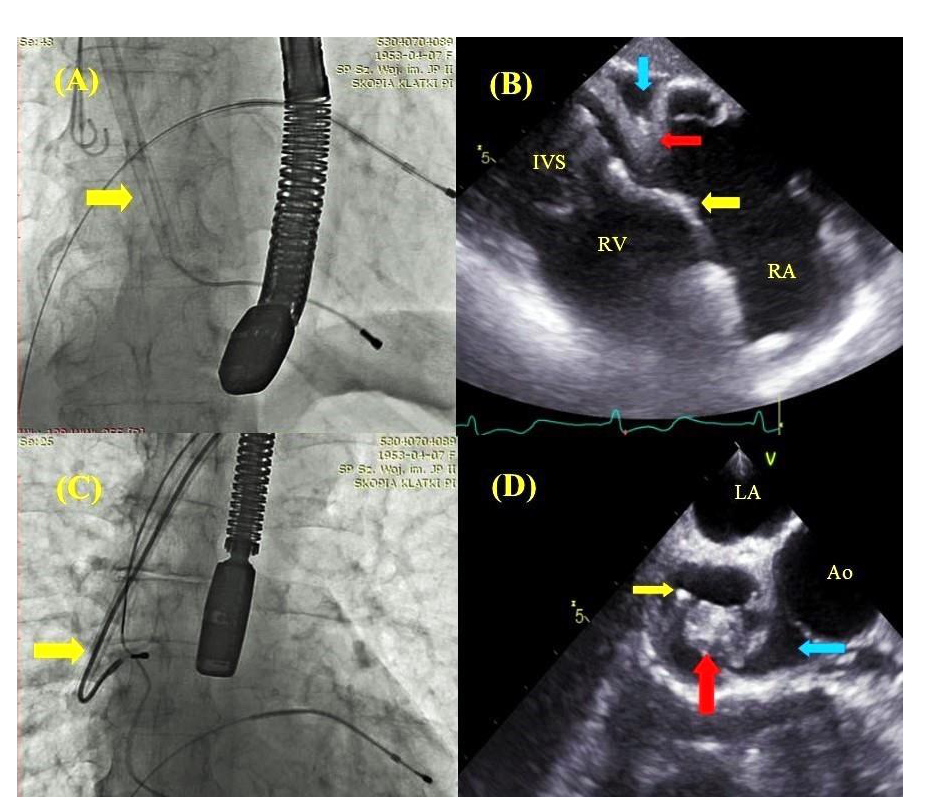
Figure 4. Comparison of fluoroscopic and echocardiographic images during lead extraction maneuvers. The moment of ventricular lead extracting; the yellow arrow points to the Byrd dilator slipped over the lead ( A ). TEE—transgastric view—the moment of ventricular lead extraction ( A ) with pulling on the right ventricular (RV) wall (red arrow), hyperechogenic thickened lead adhered to the endocardium (yellow arrow), the separation of pericardial layers corresponding to pseudo-cardiac tamponade (blue arrow) ( B ). The moment of atrial lead extraction; the yellow arrow points to the Byrd dilator slipped over the lead ( C ). TEE—mid-esophageal view; simultaneous atrial lead extraction (yellow arrow) ( C ), right atrial appendage prolapse into the atrial lumen (red arrow) and the separation of pericardial layers corresponding to pseudo-cardiac tamponade (blue arrow) ( D